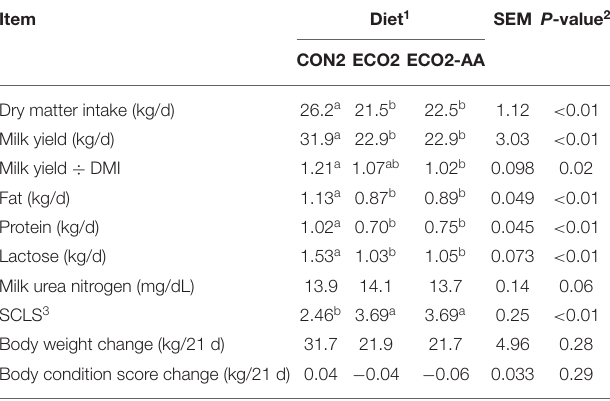
TABLE 9 | Performance of late-lactating cows fed a conventional lactation diet or by-product-based diets (Experiment 2).